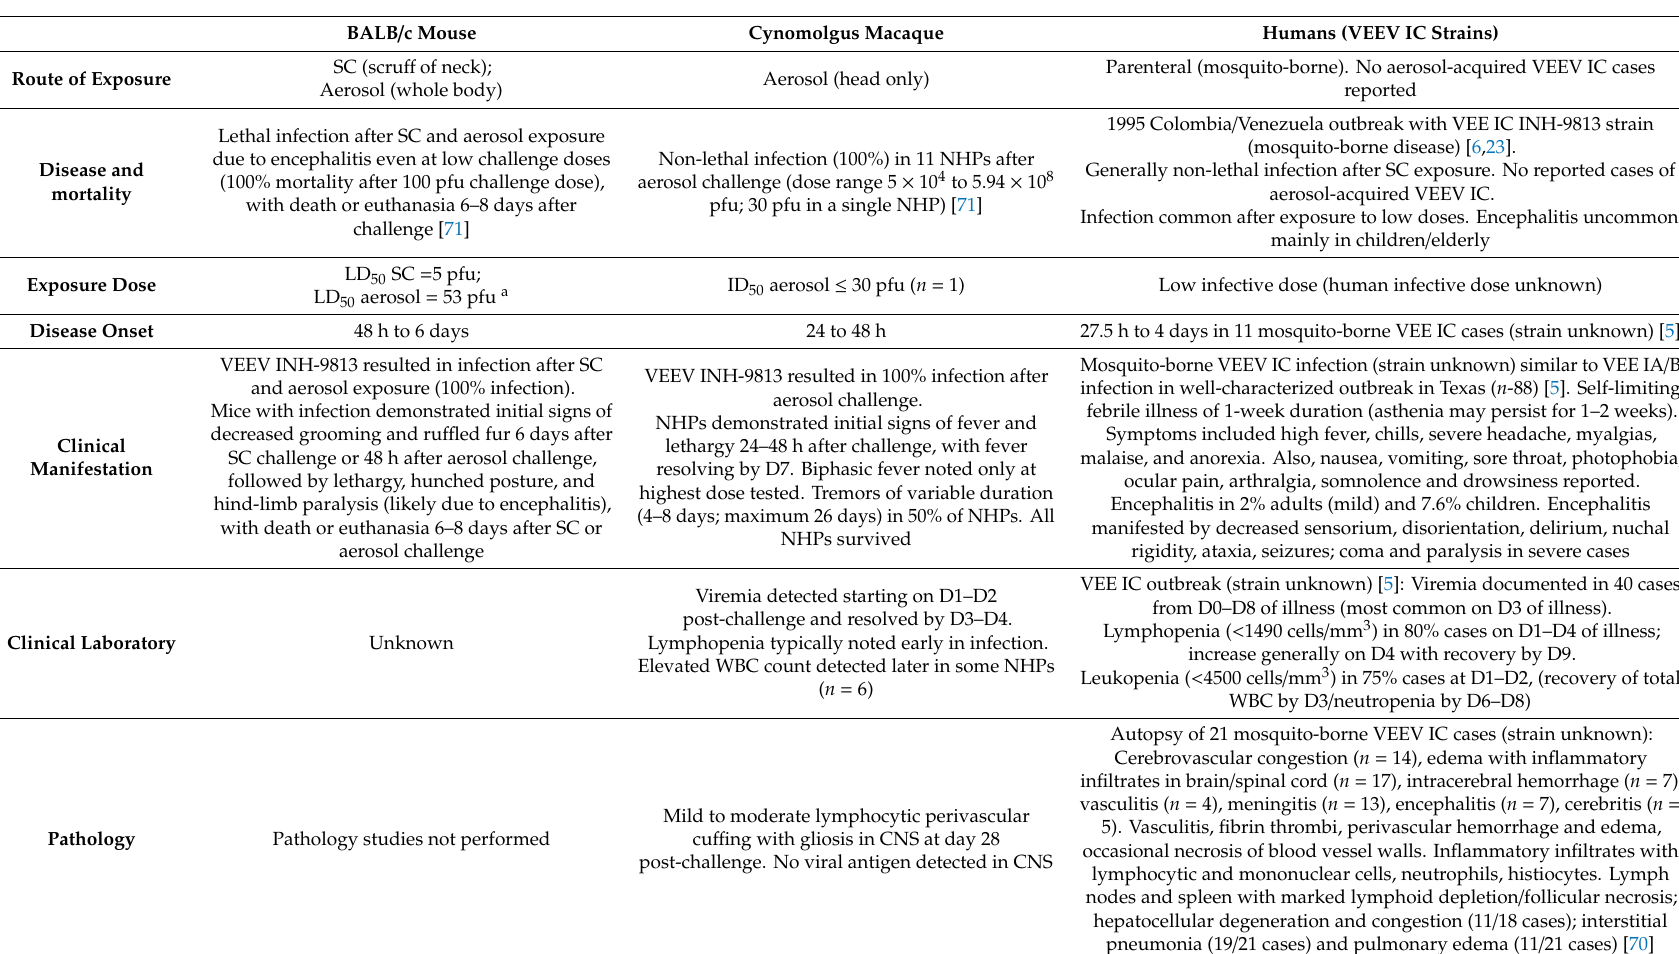
Table 5. Summary of the selected VEEV IC INH-9813 strain in mice, nonhuman primates (NHPs), and humans. BALB / c